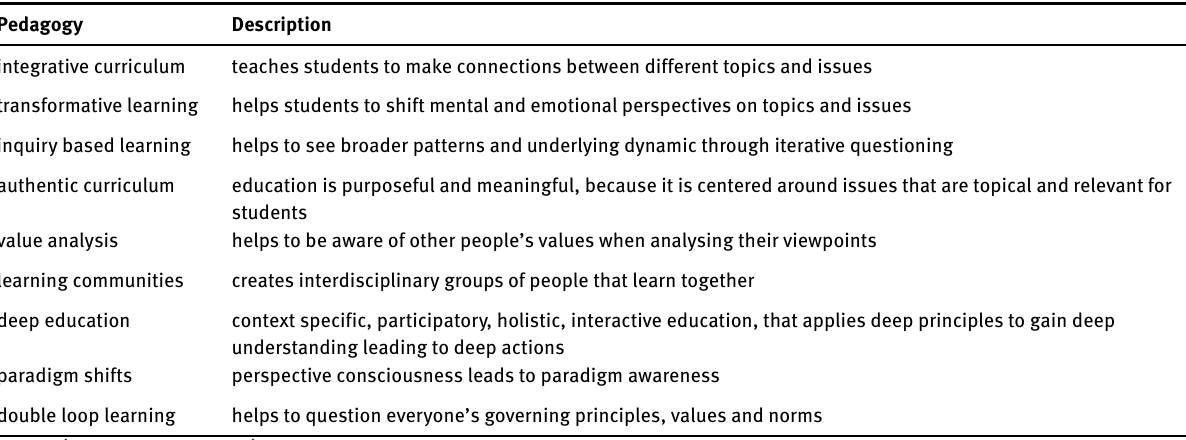
Table 1: Transdisciplinary pedagogies